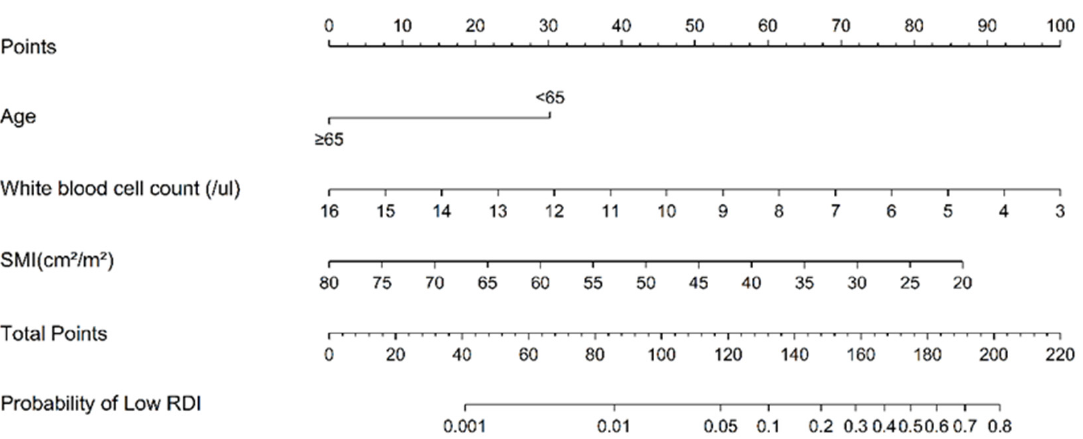
Figure 2. Nomogram used to estimate the probability of low relative dose intensity (RDI) in stage III CRC with adjuvant FOLFOX chemotherapy. SMI, skeletal muscle index.